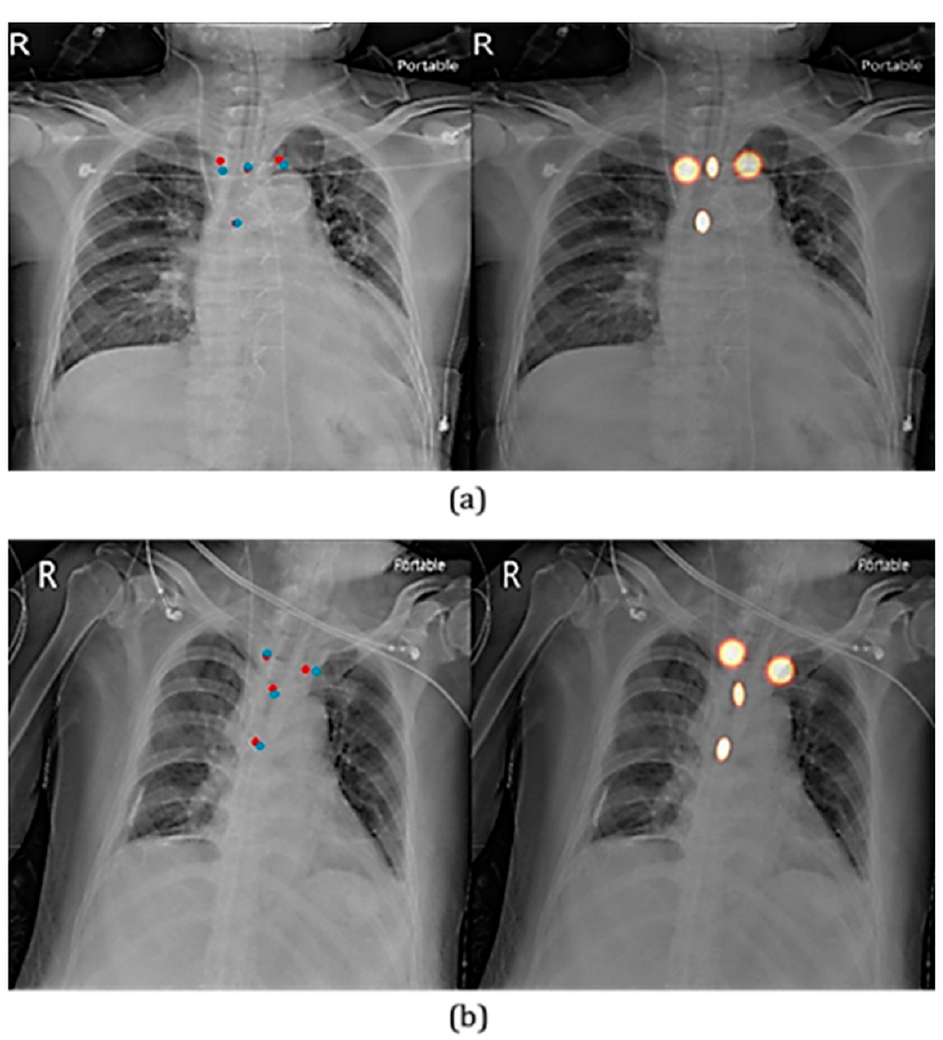
Figure 4. Visualizations of predicted key points. ( a ) Mandible above C7. ( b ) Mandible below C7. The right panel of each row illustrates the predicted heatmaps of key points, while the left panel shows the locations of predicted key points (in blue) and ground truths (in red).